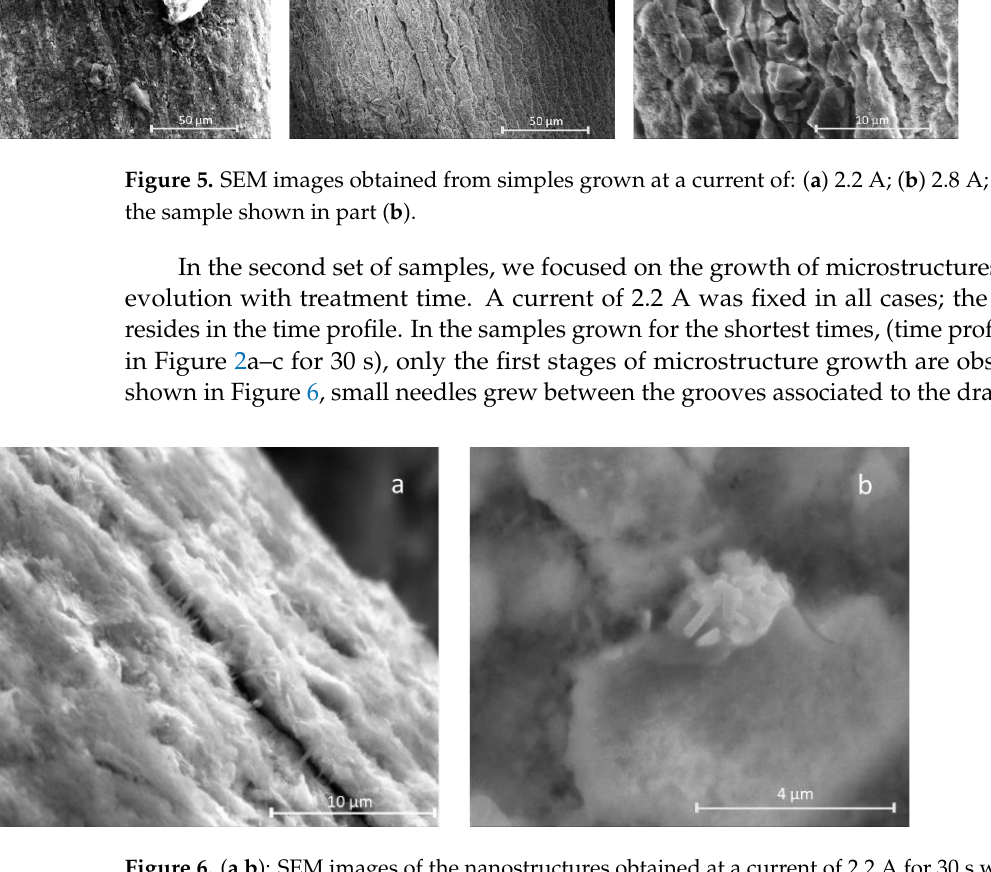
Figure 6. ( a , b ): SEM images of the nanostructures obtained at a current of 2.2 A for 30 s which shows needles between the grooves associated to the drawing lines